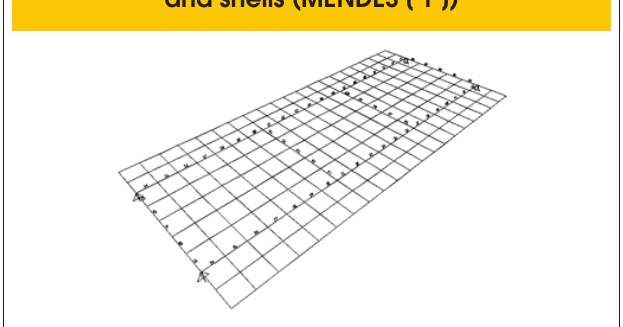
= 18.0 MPa was ad - ck Figure 8 – Model with solid finite elements (MENDES [1]